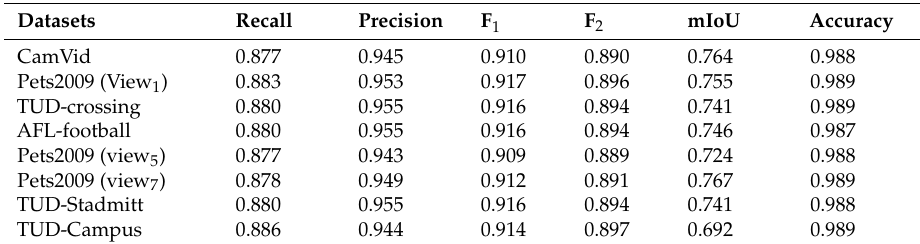
Table 2. Quantitative results of our PedNet on 8 different datasets.